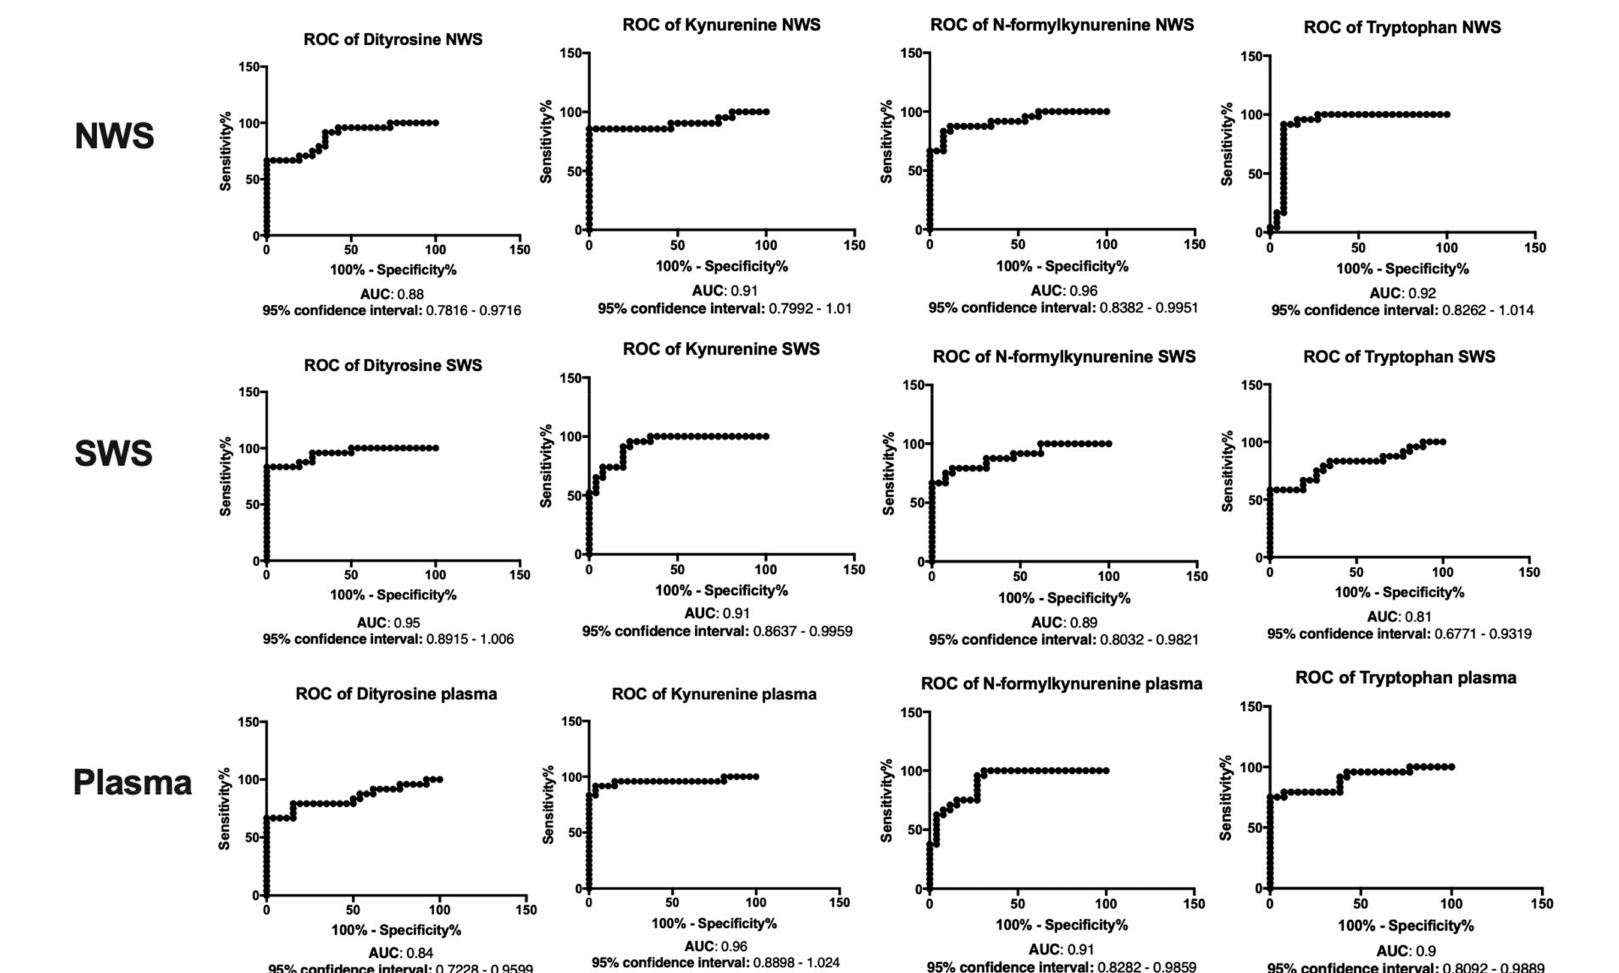
Figure 8. Receiver operating characteristic (ROC) analysis of protein glycoxidation products in non-stimulated and stimulated saliva as well as plasma of patients in di ff erent stages of dementia. Abbreviations: AUC—area under the curve; NWS—non-stimulated whole saliva; PC—protein carbonyls; SWS—stimulated whole